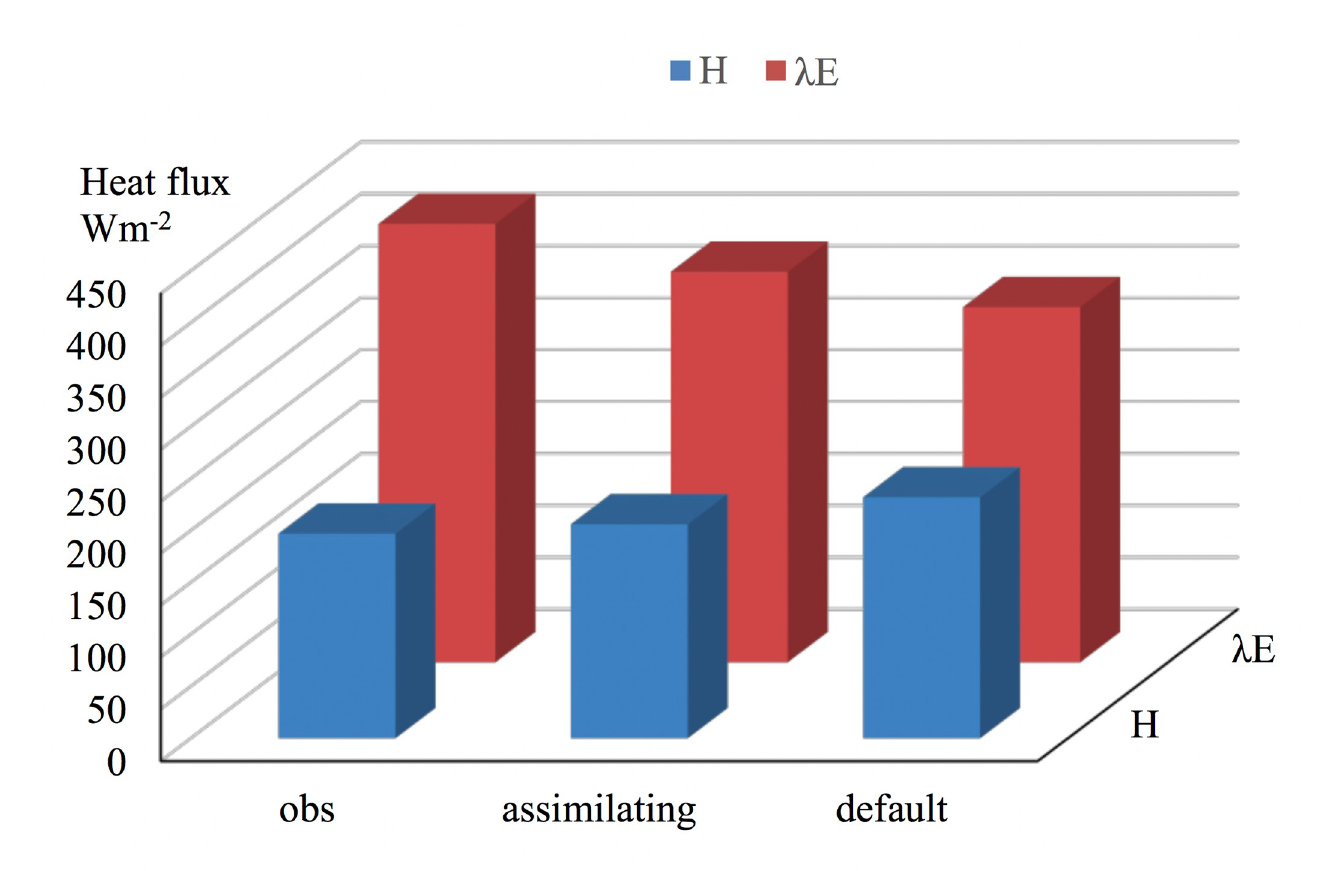
Fig 5. Comparisons of the mean sensible and latent heat fluxes obtained from the in situ data, default model configuration and assimilation experiment.